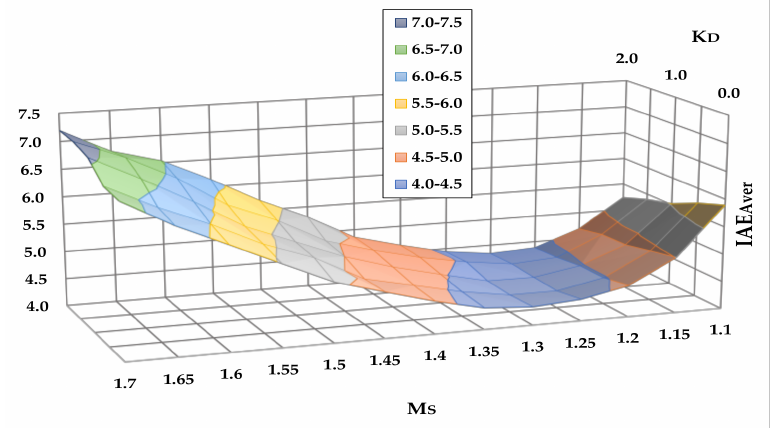
Figure 9. IAE Aver as a function of M s , k D for SP a = 400 mm H 2